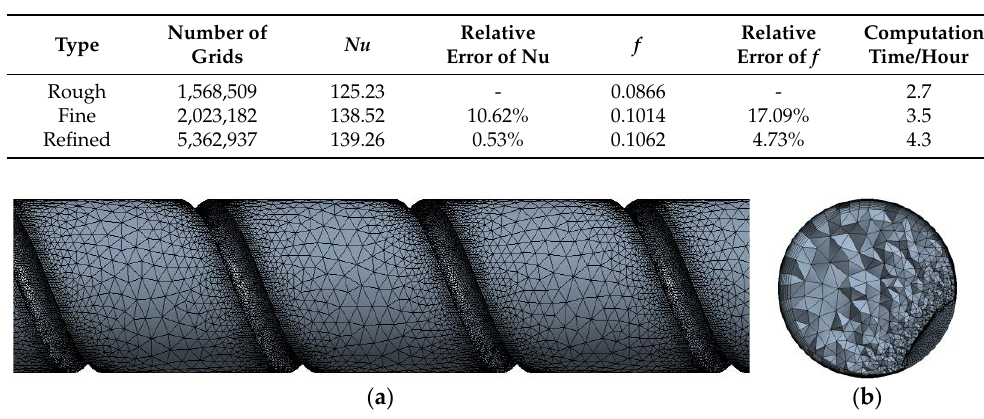
Table 2. Physical property of the fluid.